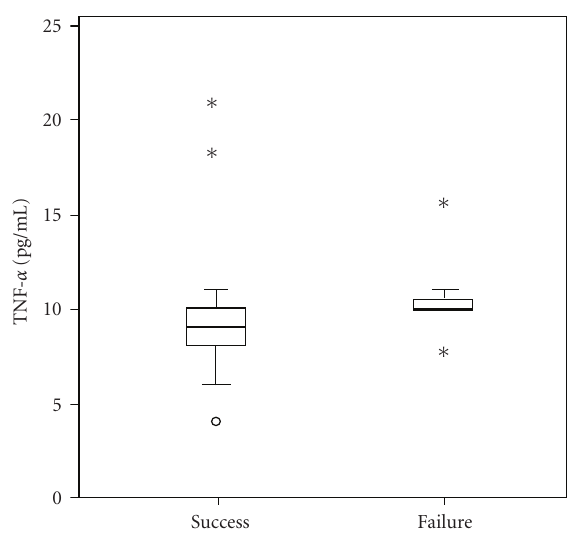
Figure 4: Aqueous levels of TNF- α in eyes with surgical success and failure 3 months after surgery ( P = . 025).